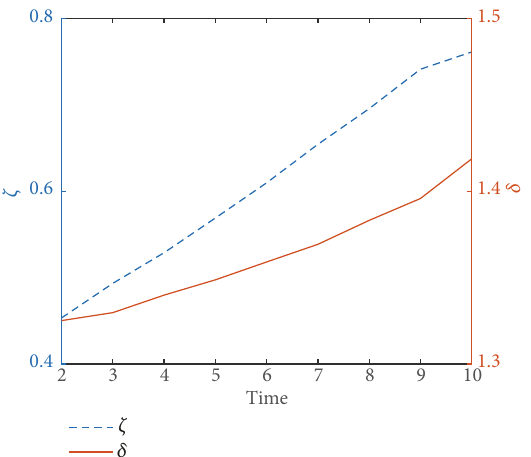
Figure 9: Hedging amounts ( 𝛿 𝑡 , 𝜁 𝑡 ) on MNormal returns.